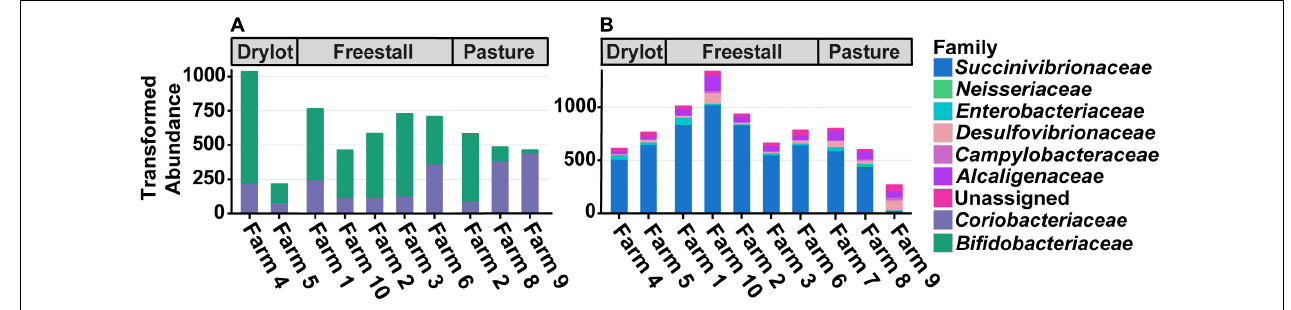
FIGURE 3 | Differences in total transformed abundance of families from (A) Actinobacteria and (B) Proteobacteria. Two out of three pasture-based farms had a decreased abundance of Bifidobacteriaceae compared to Coriobacteriaceae while the other had the reverse, mirroring many of the other farms. Both housing type and farm significantly affect the ratio of the two families ( p ≤ 0.05). Farm 9 that was strictly pasture-based had the lowest abundance of Succinivibrionaceae and the highest amount of Campylobacteraceae and Desulfovibrionaceae . These trends are not seen on Farm 7 and 8, which are pasture-based as well, but did receive grain supplementation.